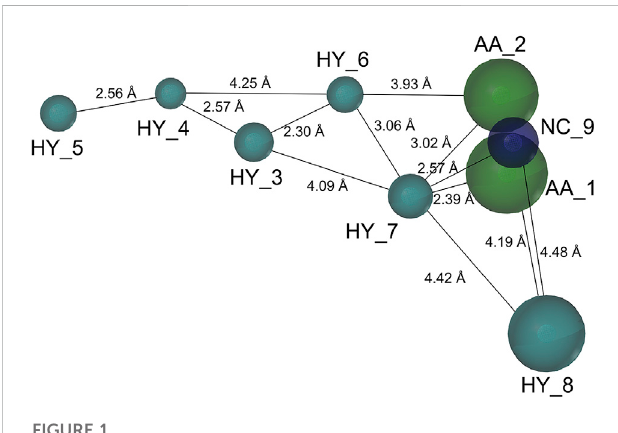
FIGURE 1 Map of a common feature pharmacophore model. AA, the atom centerofthehydrogenbondacceptor;HY,hydrophobicgroup;andNC, negative